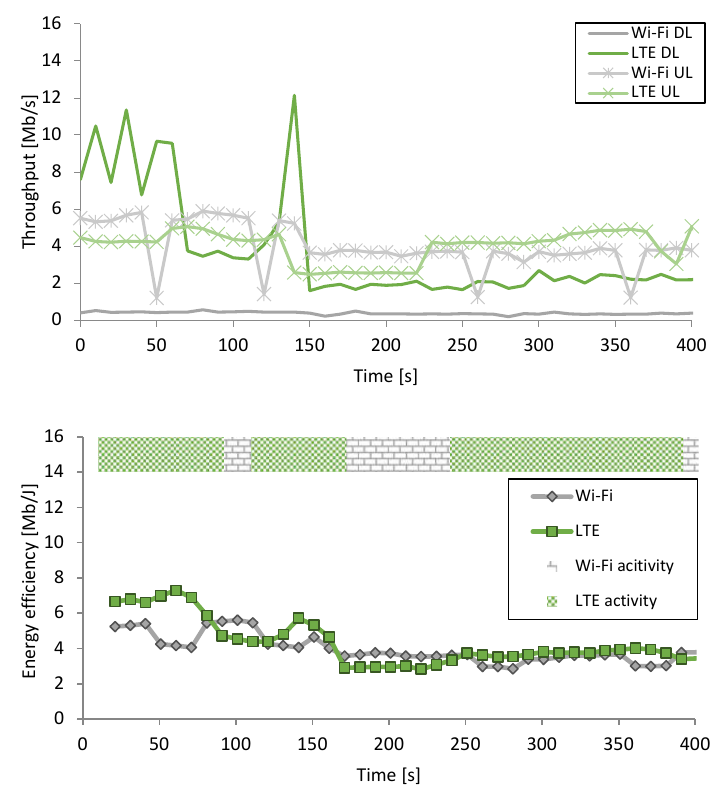
Figure 7. Scenario B—( Top ) Instantaneous throughput from UE perspective. ( Bottom ) Energy efficiency from UE perspective for different RAT with the indication which network is selected by the orchestrator to maintain user data transfer.